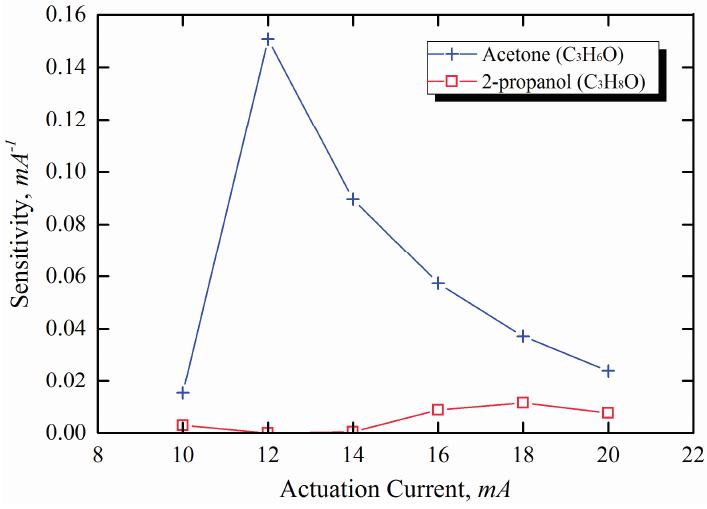
Figure 10. Actuation current dependence of sensitivity for microcantilever-based sensor. The effect of sensor performance on the variation in concentration was explored numerically in this study. Because of the high vapor pressure of acetone, the mole fraction of acetone in a binary gas mixture is much higher than that of 2-propanol, as shown in Table 1. A mixture of air and acetone can therefore be regarded as a richer mixture (lower air-fuel ratio, AFR). Hence, this reaction, being diffusion-limited, is controlled by the oxygen concentration. As shown on the right-hand side of Figure 11, by reducing the concentration of acetone, the mixture yields a higher AFR, and the temperature is increased. However, because a mixture of air and 2-propanol is lean, the surface temperature is also decreased when the concentration of gas is reduced by a factor of